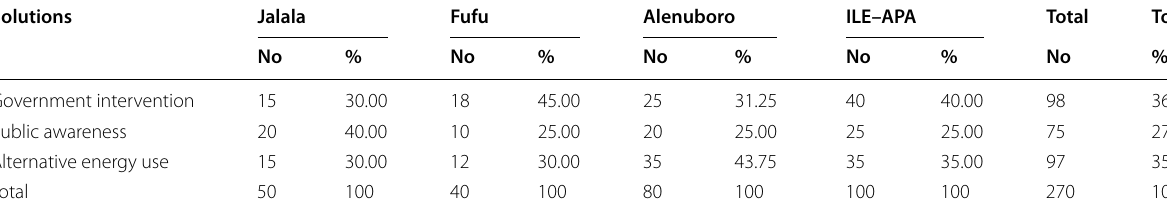
Table 9 What can be done to curb climate